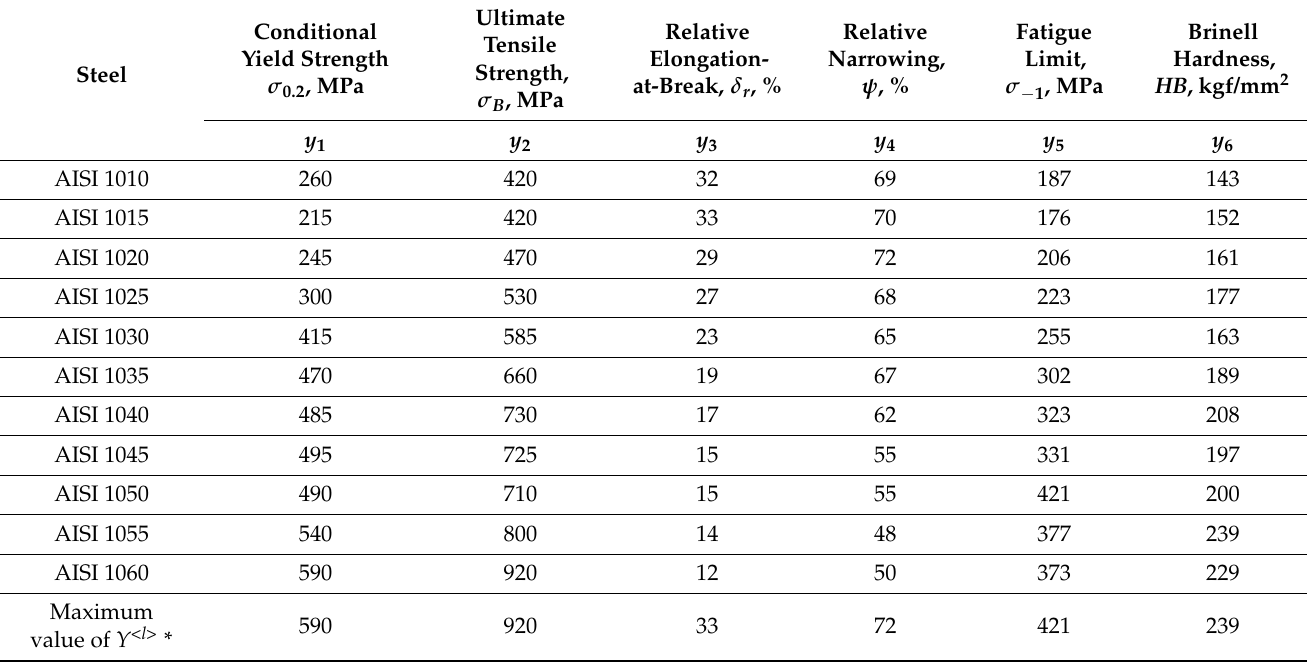
Table 2. Mechanical properties. Adapted from